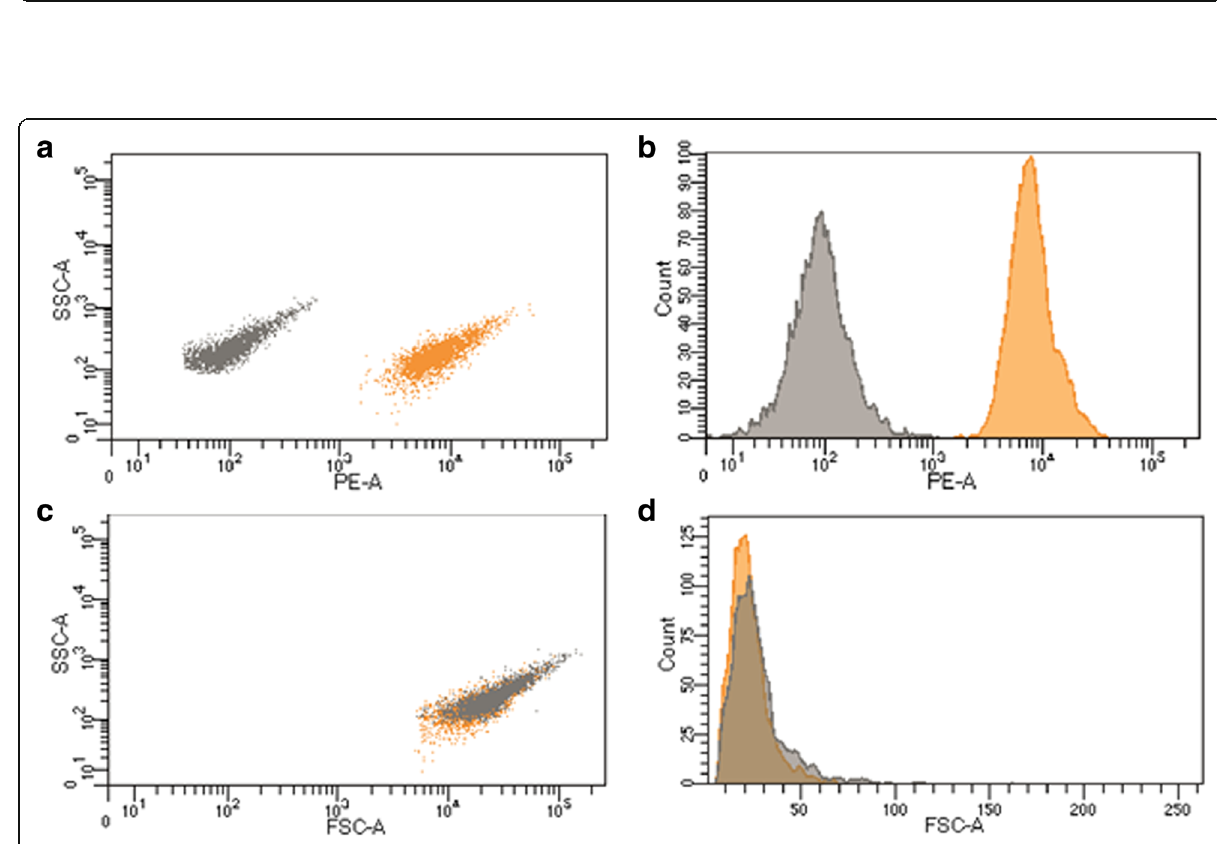
Fig. 3 The effect of quantum dot (QD) incorporation into the polymer membrane of the microbeads (MCBs) and microcapsules (MCCs) on their fluorescence characteristics: The fluorescence spectrum of a QD solution containing 2.241 mg of QDs is shown; this corresponds to the amount of QDs used for the optical encoding of the MCBs